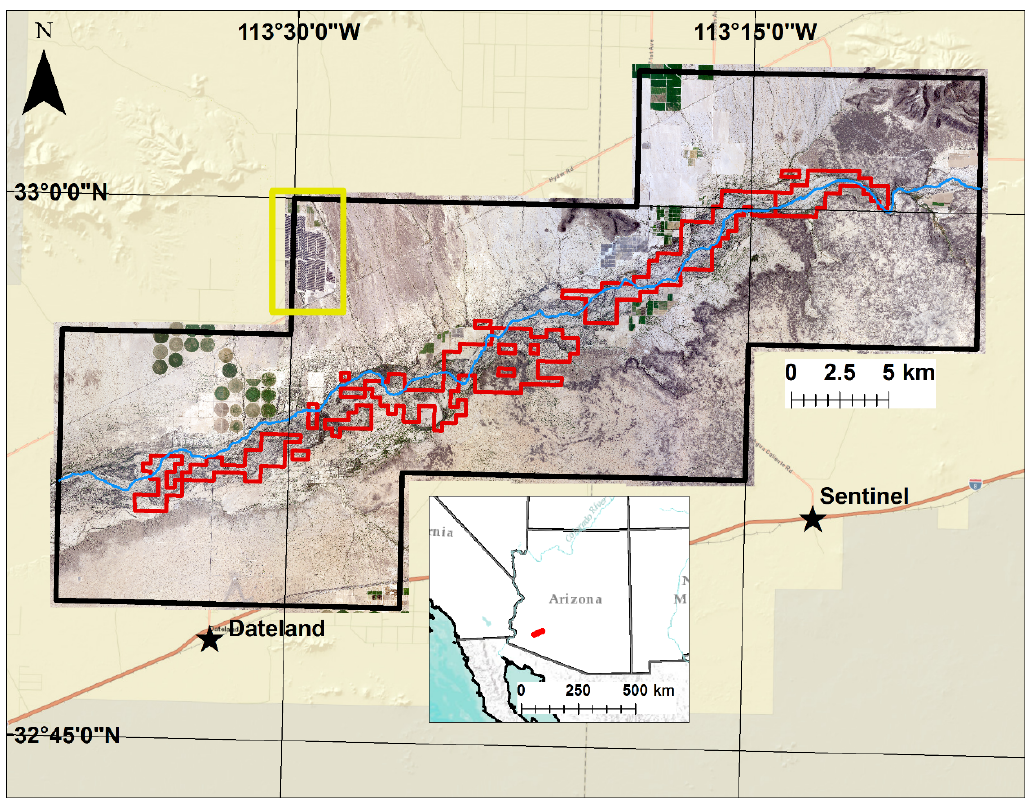
Figure 1. Location of Study Area. Our study area, indicated in black on the inset map, is composed of a nearly 50 km stretch of the Gila River located between Sentinel, AZ (east) and Dateland, AZ (west). This 60 cm natural color National Agriculture Imagery Program (NAIP) image from 2019 shows private agricultural land use both north and south of the Gila River (blue line). The area outlined in yellow was converted from agriculture into a solar energy facility after 2010. Lands managed by the Bureau of Land Management (BLM) are outlined in red, which also delineates the extent of the light detection and ranging (LiDAR) collection used in this paper. Cities of interest are shown as black stars.